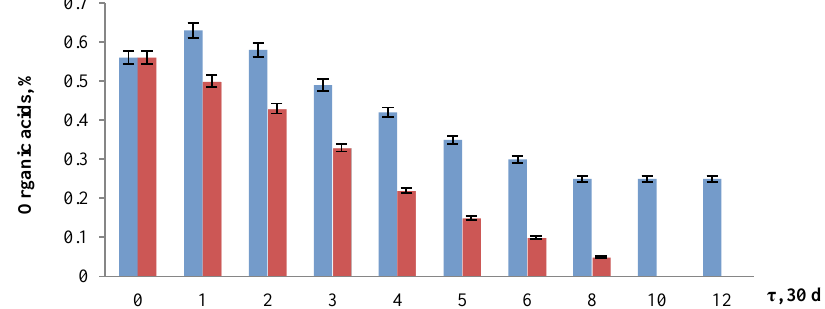
Fig. 6. Organic acids content of dates during storage at +4 °C and −18